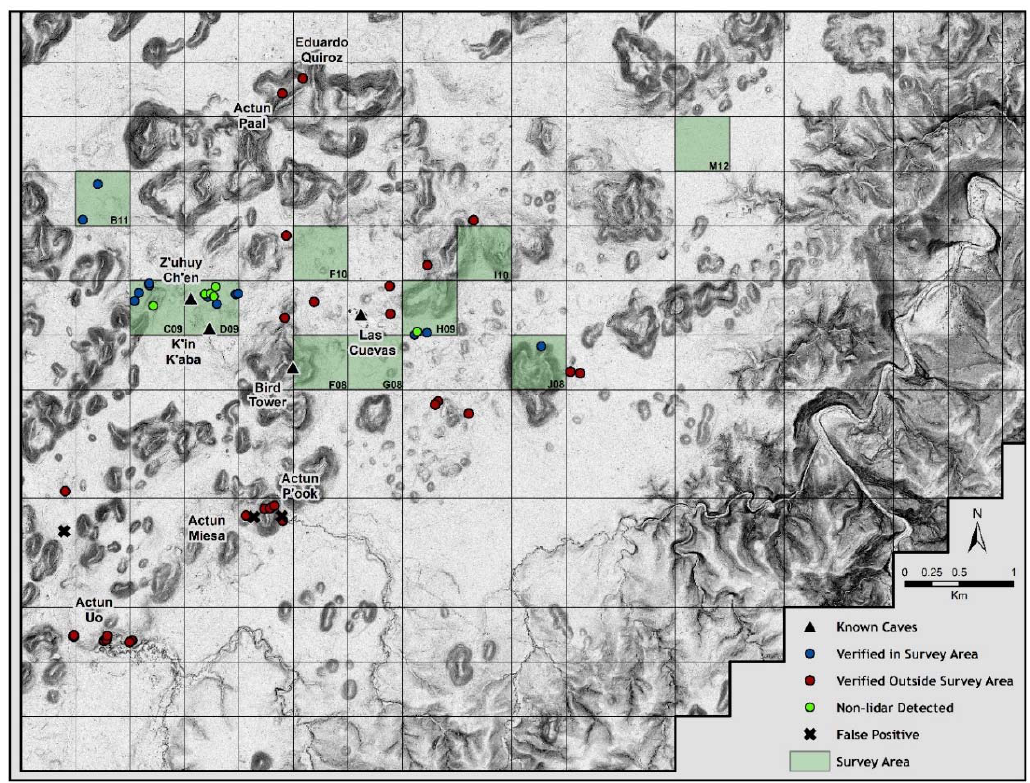
Figure 10. Map of pedestrian survey area for 2017/2018 field seasons. Green tiles indicate area systematically surveyed.